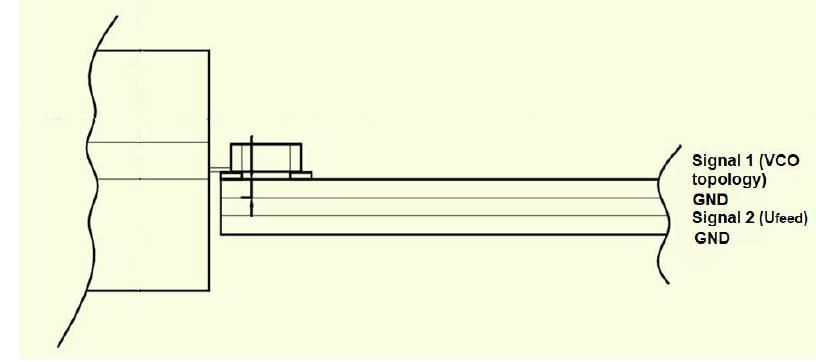
Fig. 3. The emergence of parasitic capacitances in ML PCB